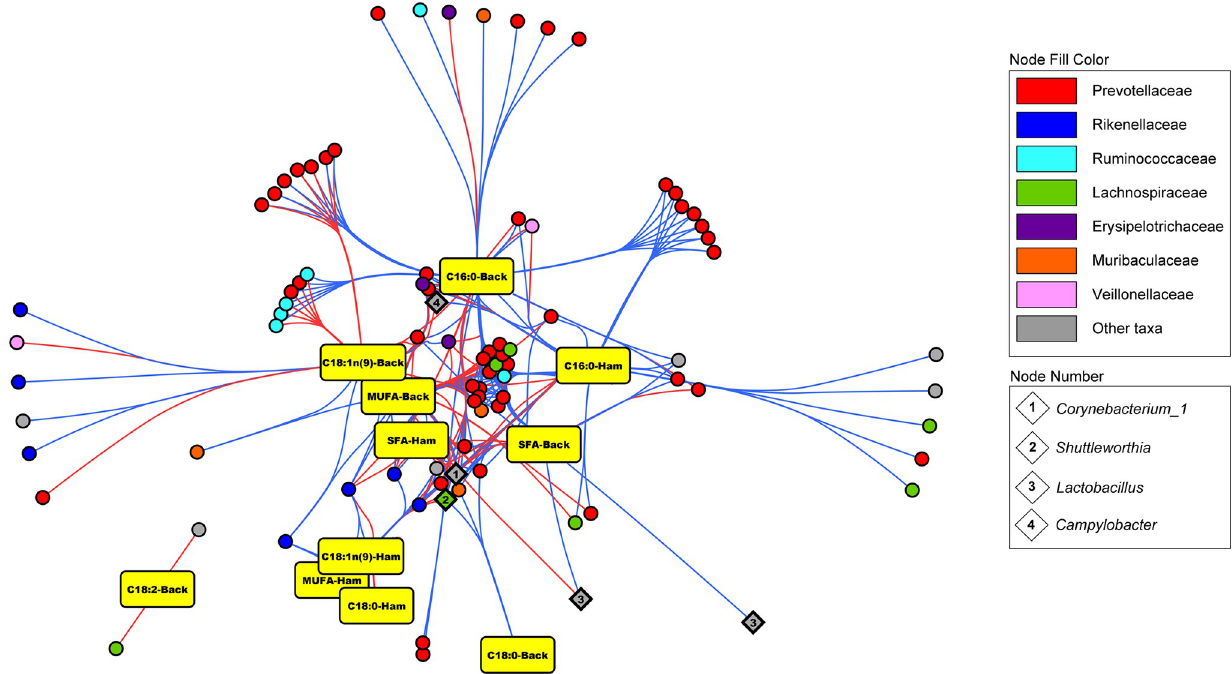
Fig 8. IB OTU-phenotype correlation network. Network representing individual OTU significant correlation with each phenotypic trait within IB subpopulation, from Limma regression analysis, when no diet correction was applied. Edge colour: red = positive correlation; blue = negative correlation. Central nodes have more connections (i.e., significantly associated to more phenotypic traits) than peripheral nodes. Numbered nodes represent OTUs classified as genera with high relevance due to their abundance patterns in our dataset.